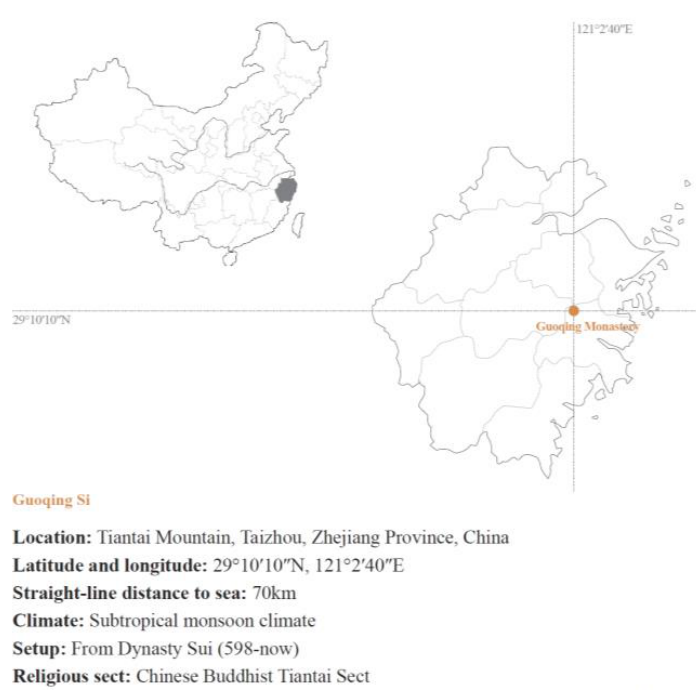
Figure 3. Diagram of the location of Guoqing Si.